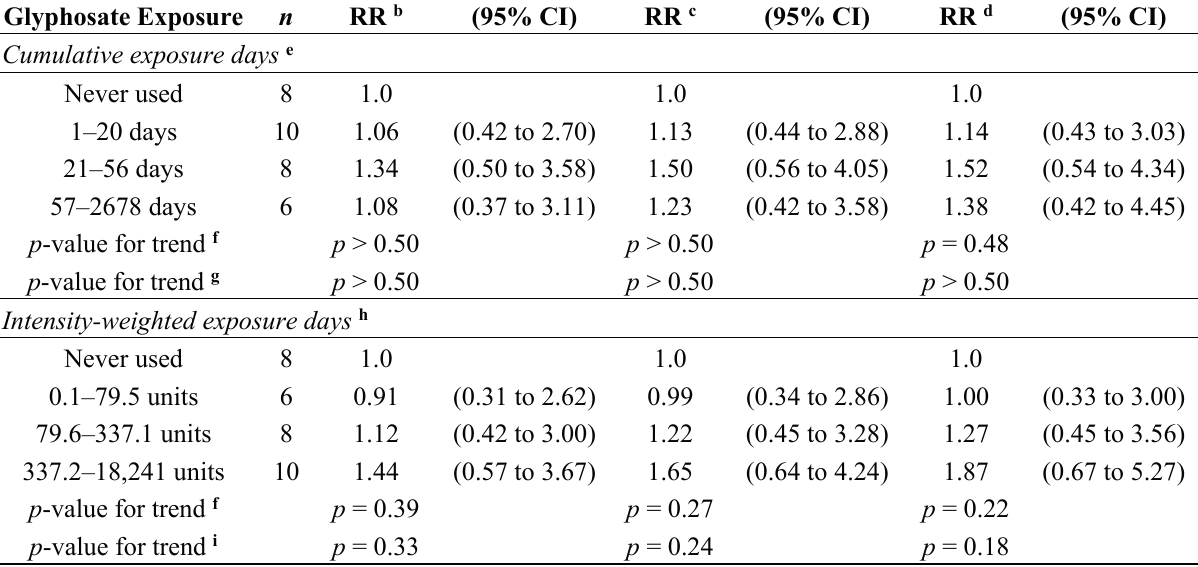
Table 3. Risks of multiple myeloma in relation to estimated glyphosate exposure (cumulative exposure days or intensity-weighted exposure days) (32 cases [29 males, 3 females] in 54,315 applicators, Set 1 data a